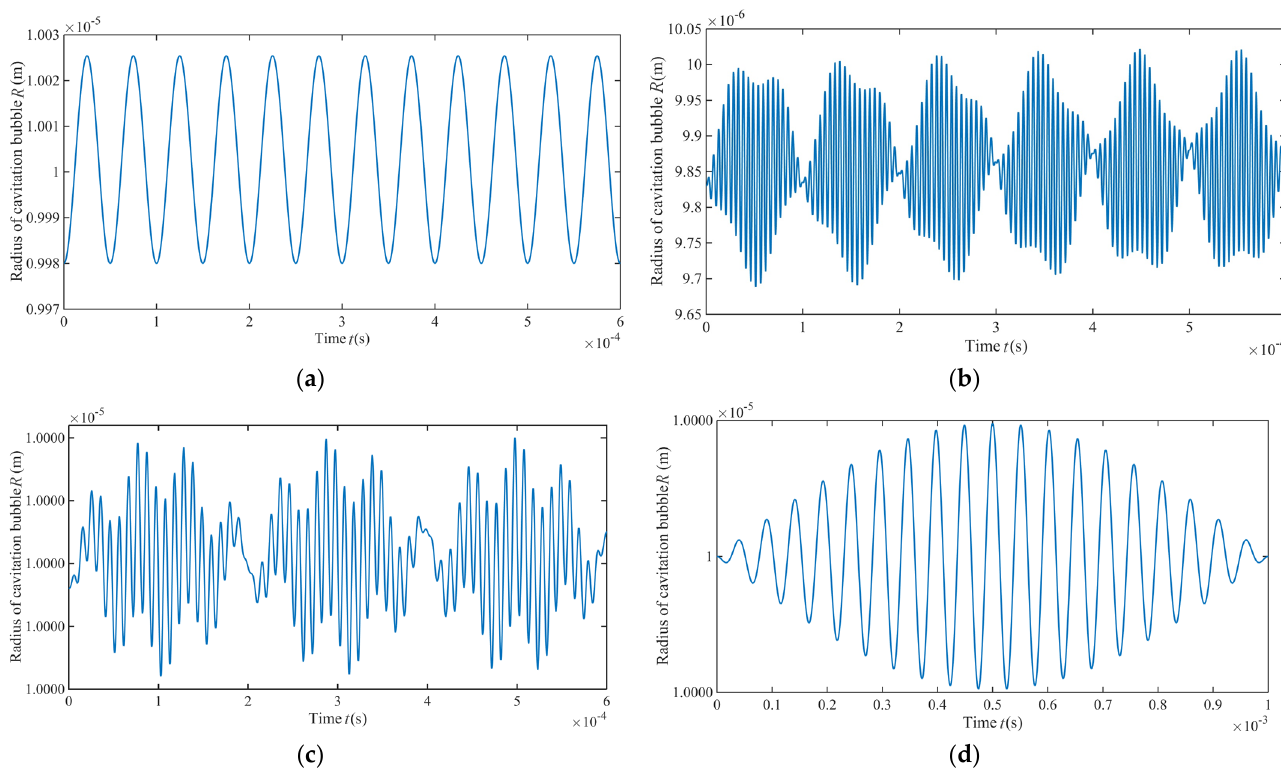
Figure 4. Variation trends of a single cavity radius in the resonance grinding zone. ( a ) i = 1; ( b ) i = 2; ( c ) i = 3; ( d ) i = 4.